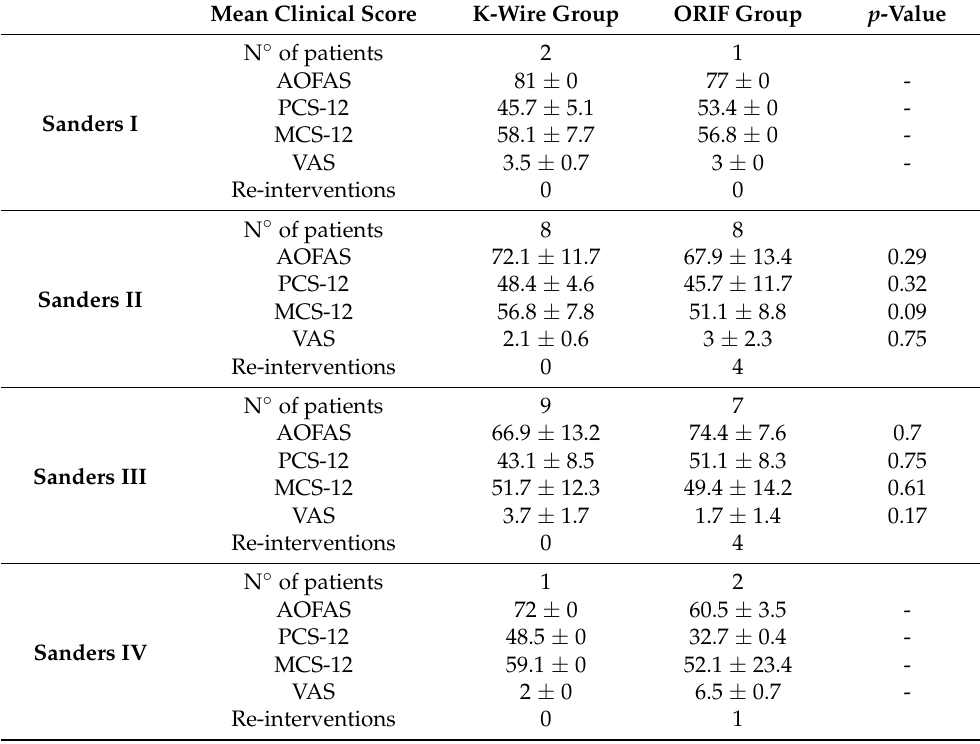
Table 3. Sub-group classification, outcomes, and re-interventions based on Sanders